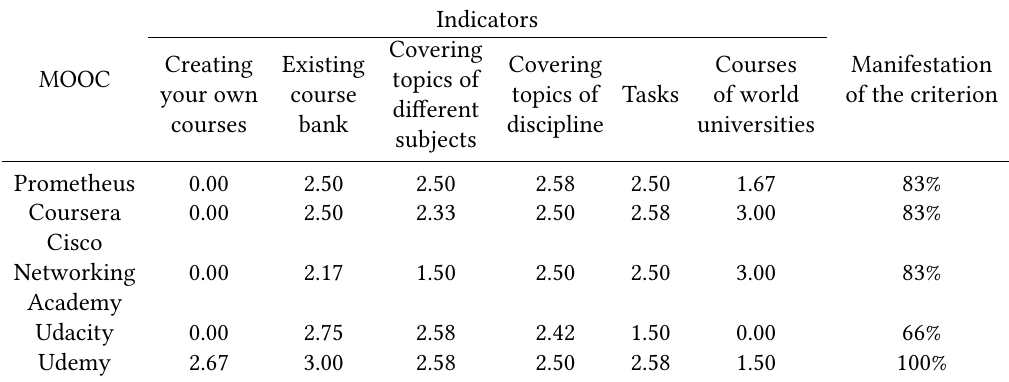
Table 8 Information and didactic criterion of MOOC platforms and its indicators.